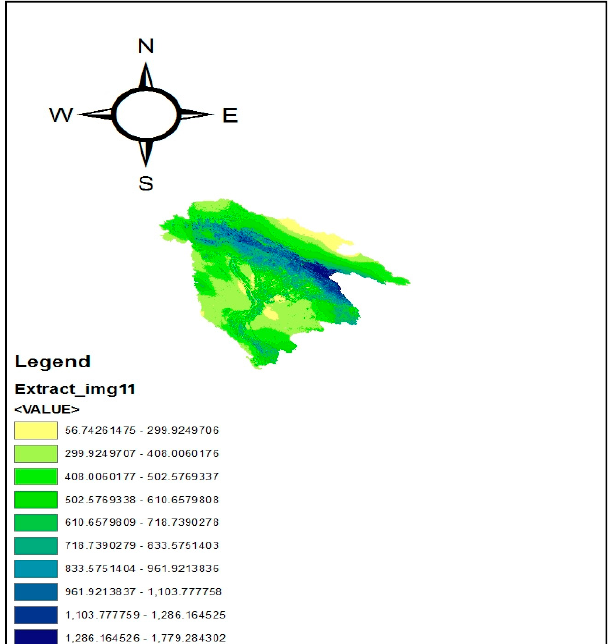
Figure 2. TRMM rainfall at 1 km resolution.